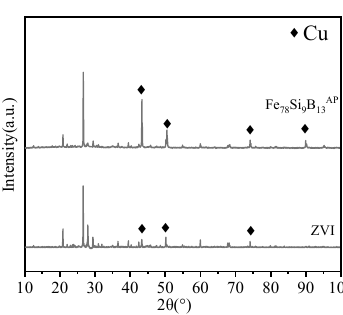
Figure 4. XRD spectra of Fe 78 Si 9 B 13 AP and ZVI after reacting with Cu 2+ ions.